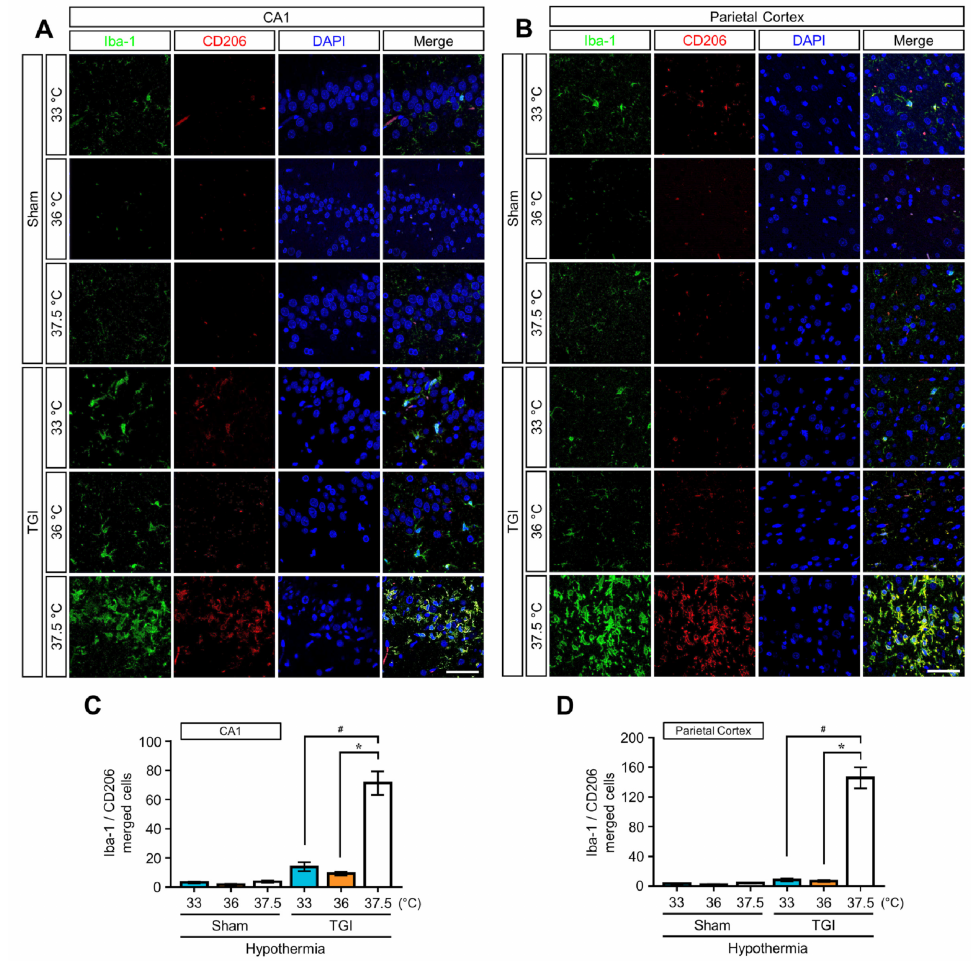
Figure 5. TTM at 33 ◦ C and 36 ◦ C suppresses changes in M2 phenotype microglia at 72 h after TGI. ( A , B ) Fluorescent imaging shows total microglia (Iba-1, green signal), the M2 type microglia (CD206, red signal), and merger with nuclei in the hippocampal cornus ammonis and parietal cortex regions. Scale bar = 50 µ m. ( C , D ) Percentage of Iba-1 and CD206 merging at the hippocampal cornus ammonis and parietal cortex regions. Iba-1 and CD206 co-localization percentage was lower in TGI-TTM at 33 ◦ C and 36 ◦ C than in TGI at 37.5 ◦ C (one way-ANOVA, multiple comparison following Bonferroni adjustment. Sham + 33 ◦ C, n = 3; Sham + 36 ◦ C, n = 4; Sham + 37.5 ◦ C, n = 6; TGI + 33 ◦ C, n = 5; TGI + 36 ◦ C, n = 8; TGI + 37.5, n = 6. * p and # p <